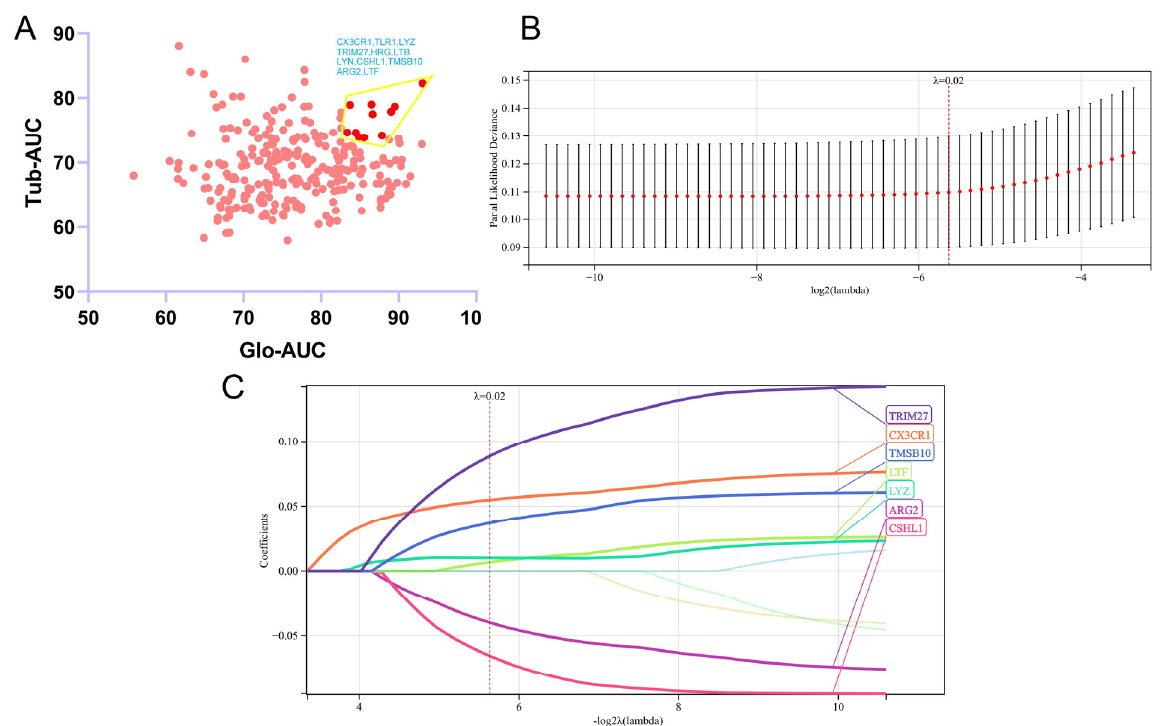
Figure 5. Gene screening and regression model establishment. ( A ) AUC − AUC plot of 274 common up-regulated or down-regulated DIRGs in data 1 and data 2, the DIRGs with top 20% AUC values both in glomeruli and tubulointerstitium are deep red. ( B ) The elastic net of 11 DIRGs in data 1. ( C ) Seven DIRGs were screened based on lambda = 0.02.